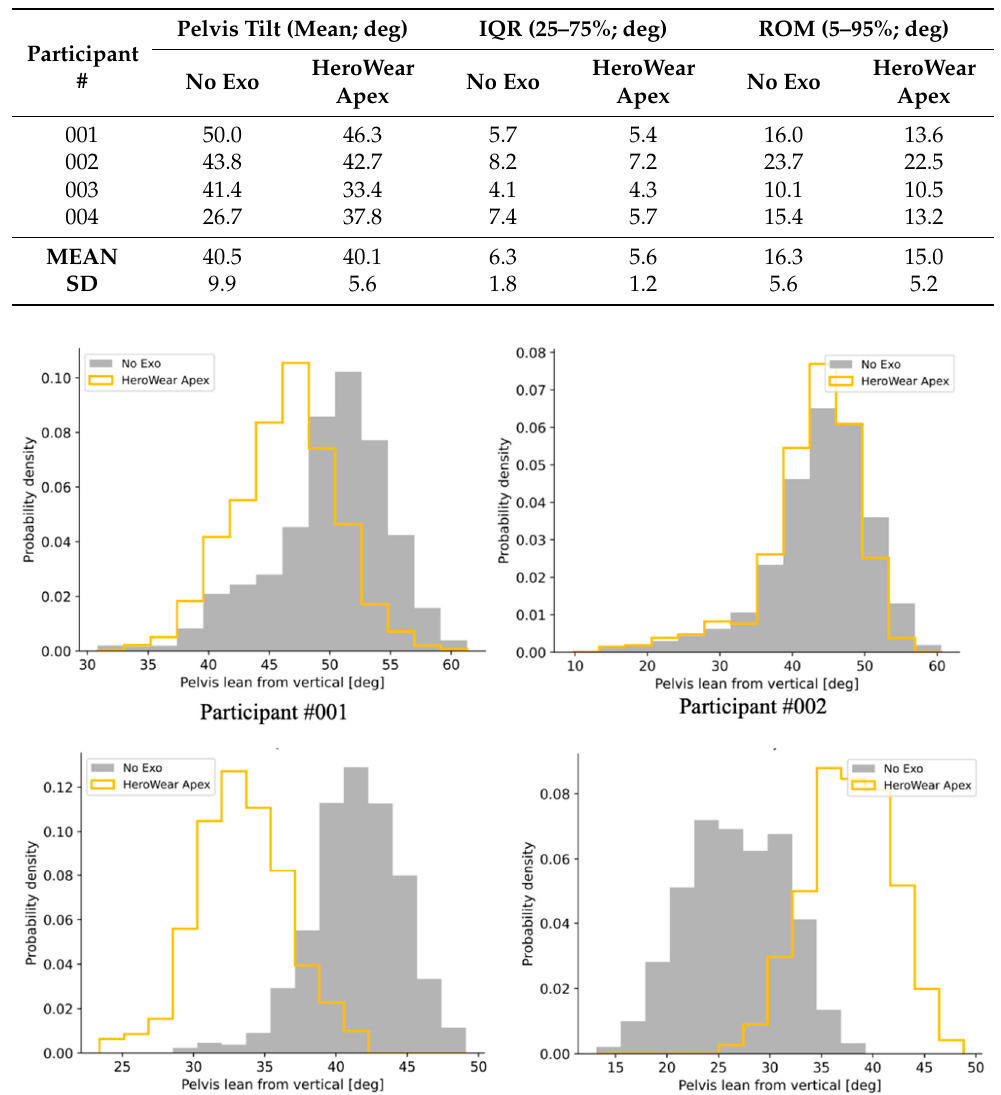
Table 3. Pelvis tilt (deg) for pushing the unloaded gondola downhill.